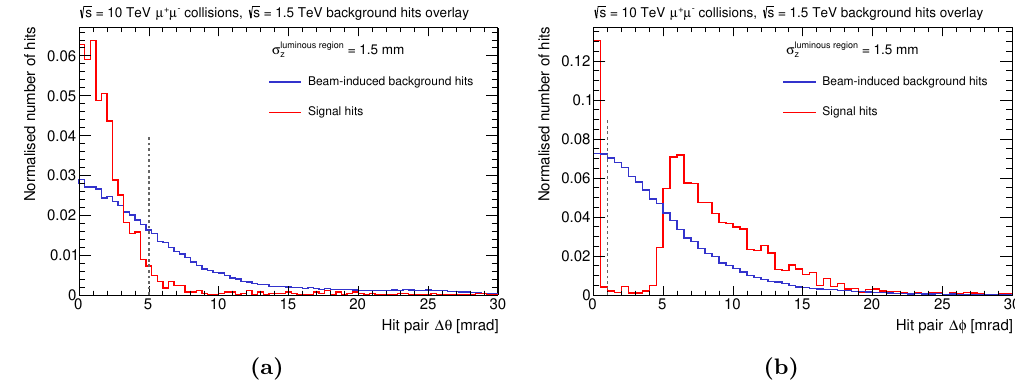
Figure 6. Distribution of the minimum polar (a) and azimuthal (b) angular difference between pairs of hits in the first double-layer of the vertex detector, in the barrel region. The dashed vertical lines indicate the maximum accepted value by the stub track selection. The double peak structure observed in (b) is due to the tracks corresponding to the low-momentum charged SM particle (typically a pion) which is produced in the ˜ χ ± decay and populates the higher ∆ φ region. Since reconstructing these low momentum tracks is not the target of our search, the corresponding detector hits are rejected by the chosen stub track